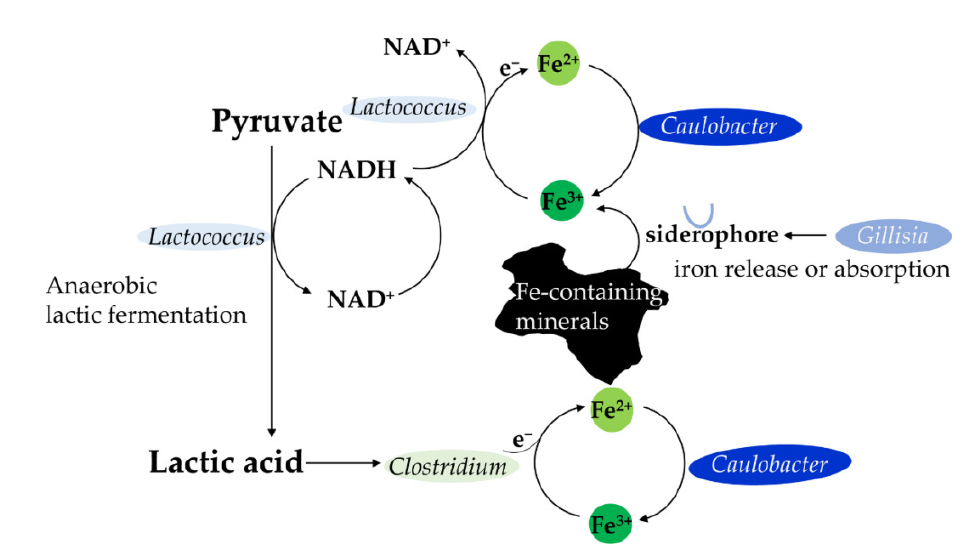
Figure 7. Iron-related geochemical cycle several dissimilatory iron reducing microorganism (DIRB) genera participate